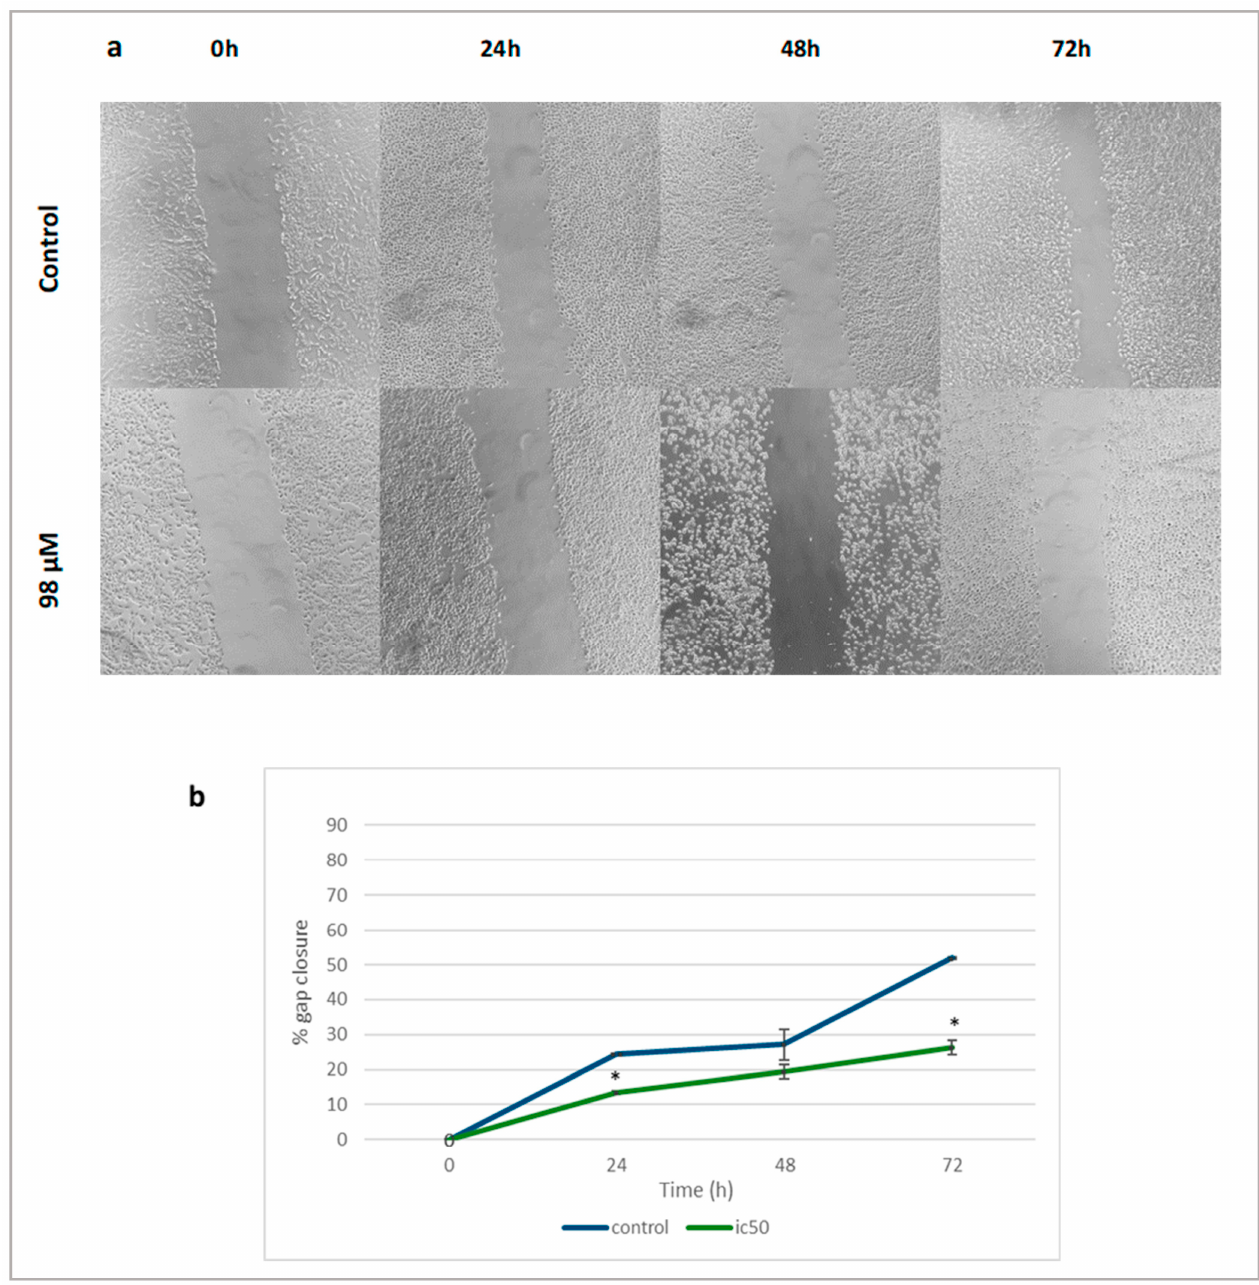
Figure 9. Microscopic images (magnification ×10, scale bars = 100 μΜ ) of scratch wound healing assay. ( a ) When U87 cells were treated with an IC50 linearol concentration, a decrease in the closure percentage was observed. ( b ) The migration ability of U87 cells showed a statistically significant decline after treatment with linearol when compared to control (98 μ M at 24 h: 13.38%, p < 0.05; 98 μ M at 72 h: 26.29%, p < 0.05). Data are presented as the mean ± SD. * p < 0.05 compared to the control group.